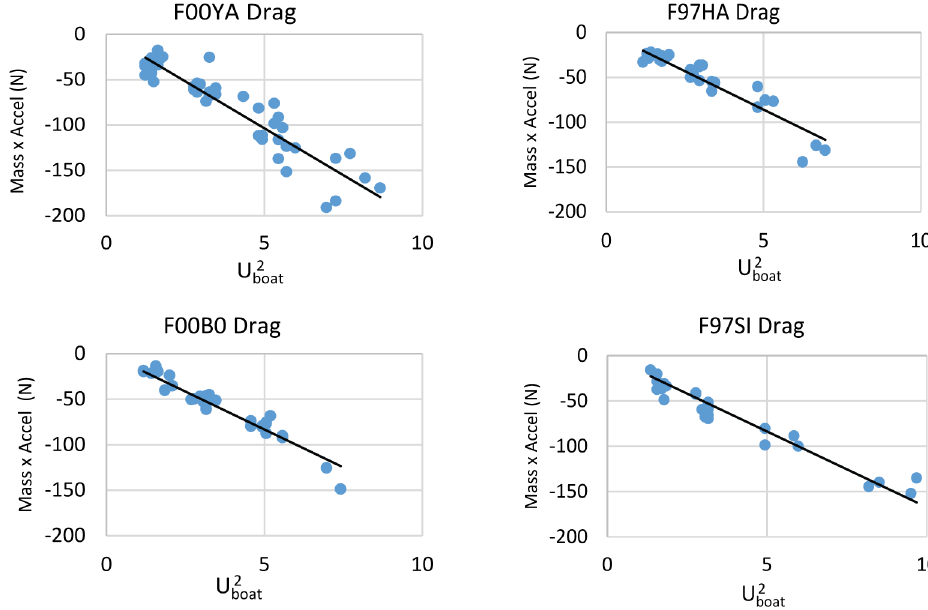
Fig 12. Time-averaged total drag, as calculated via Eg. 5, versus squared-boat speed.